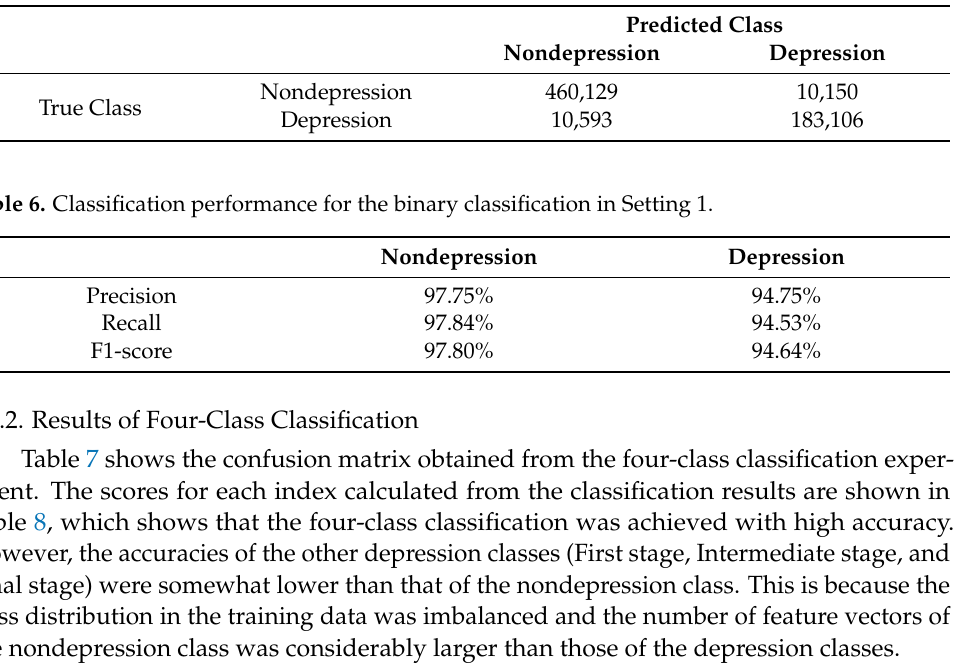
Table 5. Confusion matrix obtained by the binary classification in Setting 1.